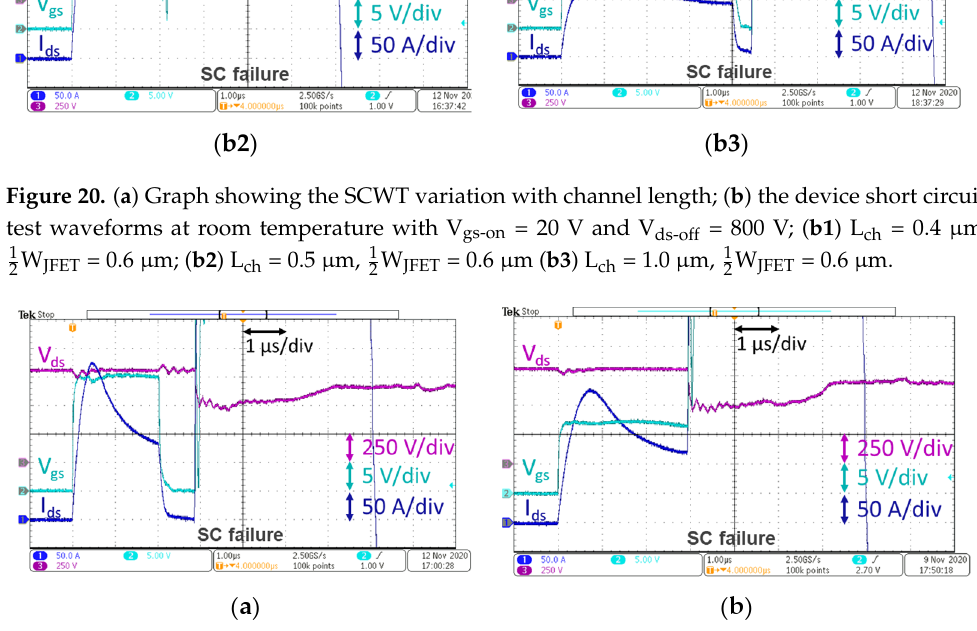
Figure 21. The device short circuit test waveforms at room temperature with V gs-on = 20 V and V ds-off = 800 V ( a ) THICKER GATE OXIDE, ½W JFET = 0.6 µm, L ch = 0.5 µm, Cell Pitch = 5.4 µm, SCWT = 2 µs; ( b ) THINNER GATE OXIDE, ½W JFET = 0.6 µm, L ch = 0.5 µm, Cell Pitch = 5.4 µm, SCWT = 2.9 µs.